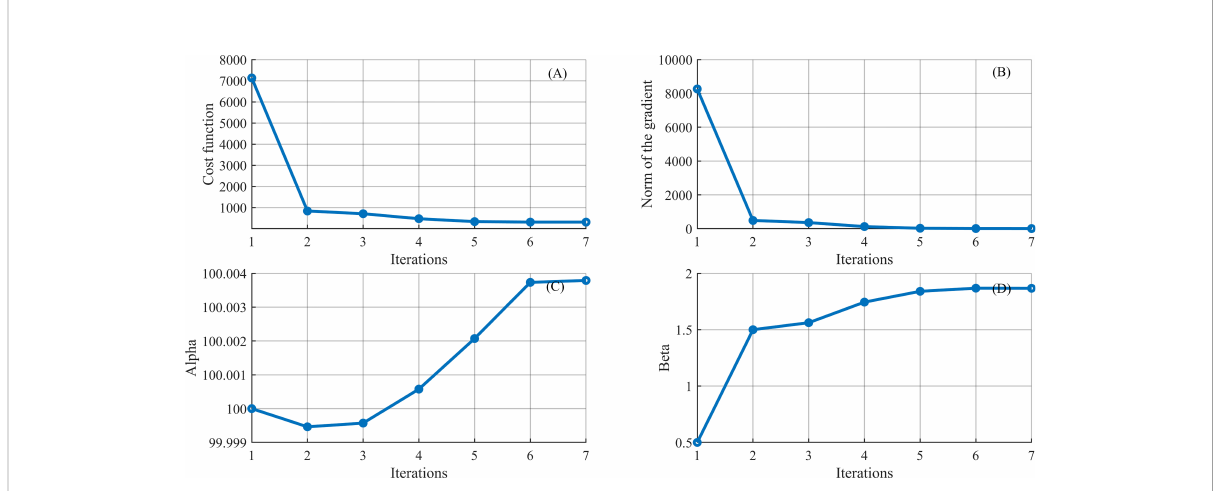
FIGURE 8 The variation of (A) the cost function, (B) the norm of the gradient, and wave-affected parameters (C) a and (D) b with LBFGS for B _ ab